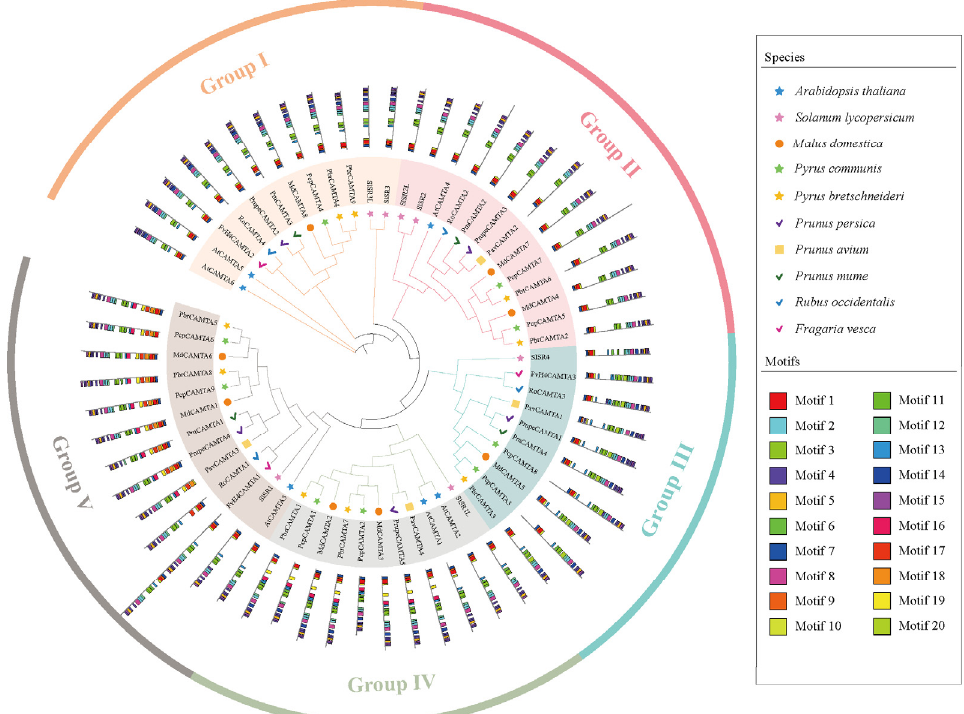
Figure 2. Phylogenetic tree and distribution of conserved motifs across the CAMTA protein family in eight Rosaceae species. The phylogenetic tree of the CAMTA protein family is constructed by iqtree using the neighbor-joining (NJ) method with 1000 bootstraps. A total of 20 motifs are predicted using the MEME tool. Among these, yellow branches indicate Group I; pink branches indicate Group II; blue branches indicate Group III; gray branches indicate Group IV; and brown branches indicate Group V. Blue star, yellow star, green star and pink star indicate the CAMTA proteins, respectively, in Arabidopsis , P. bretschneideri , P. communis , and S. lycopersicum . Pink tick, green tick, purple tick, and blue tick indicate CAMTA proteins, respectively, in F. vesca , P. mume , P. persica , and R. occidentalis . The orange circles and squares represent CAMTA proteins in M. domestica and P. avium .